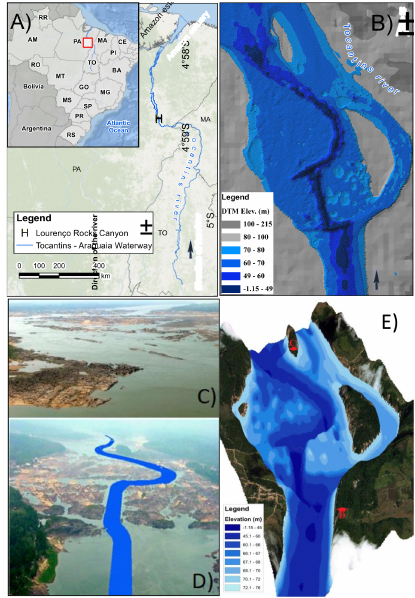
Figure 1. ( A ) Geographic location of the Tocantins River and the canyon location at Lourenço’s Rock; ( B ) Bathymetrical map (above sea level); ( C ) Image looking downstream during low flow condition; ( D ) Image looking upstream during low flow conditions and indicating the navigation channel; ( E ) 3D bathymetrical visualization (vertical exaggeration = 15) overlaid on a satellite image and ( C , D ) viewing